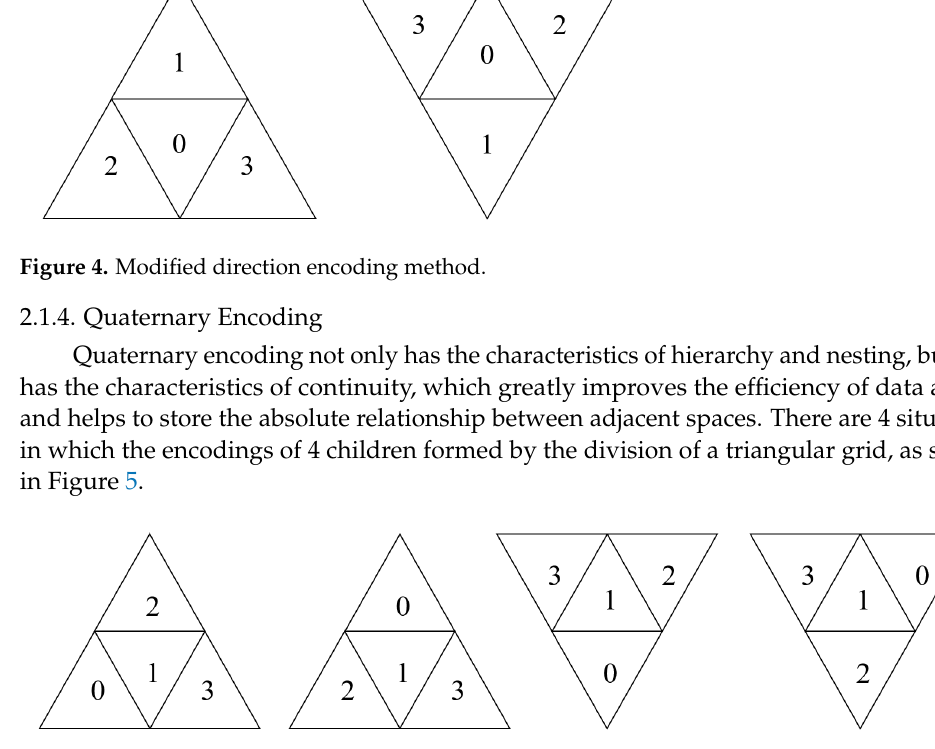
Figure 5. Quaternary encoding method.